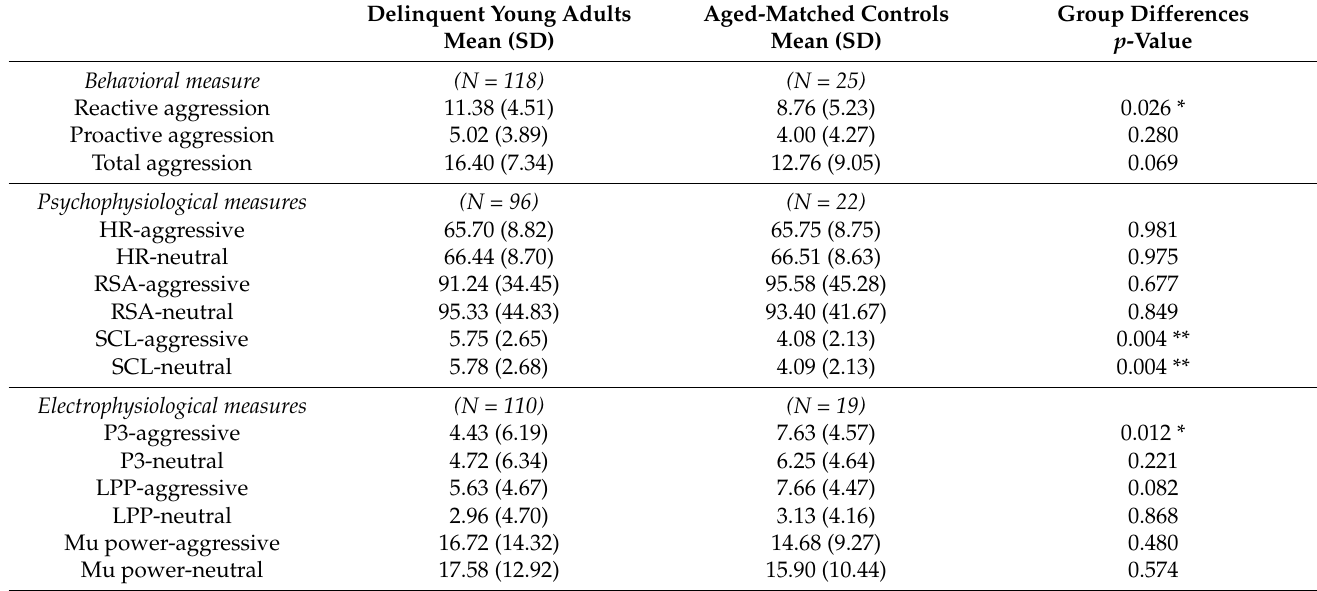
Table 2. Descriptive statistics and comparative results of behavioral and neurobiological measures ( N =